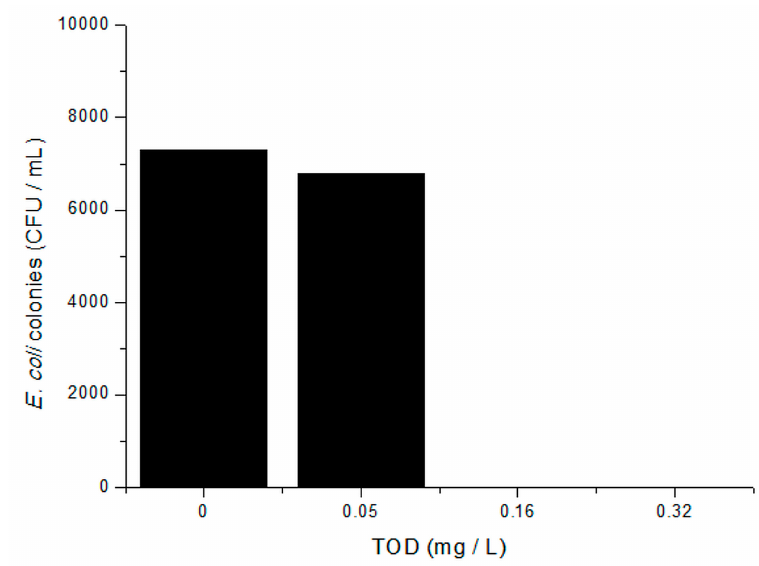
Figure 2. E. coli in synthetic wastewater as function of TOD during single ozonation (based on [126]).